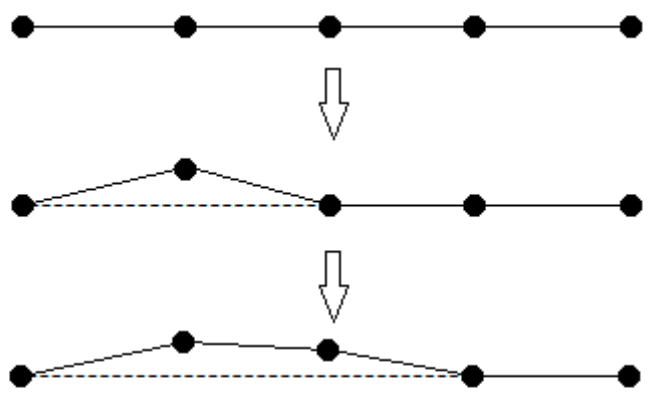
Figure 3. Gradient search strategy.